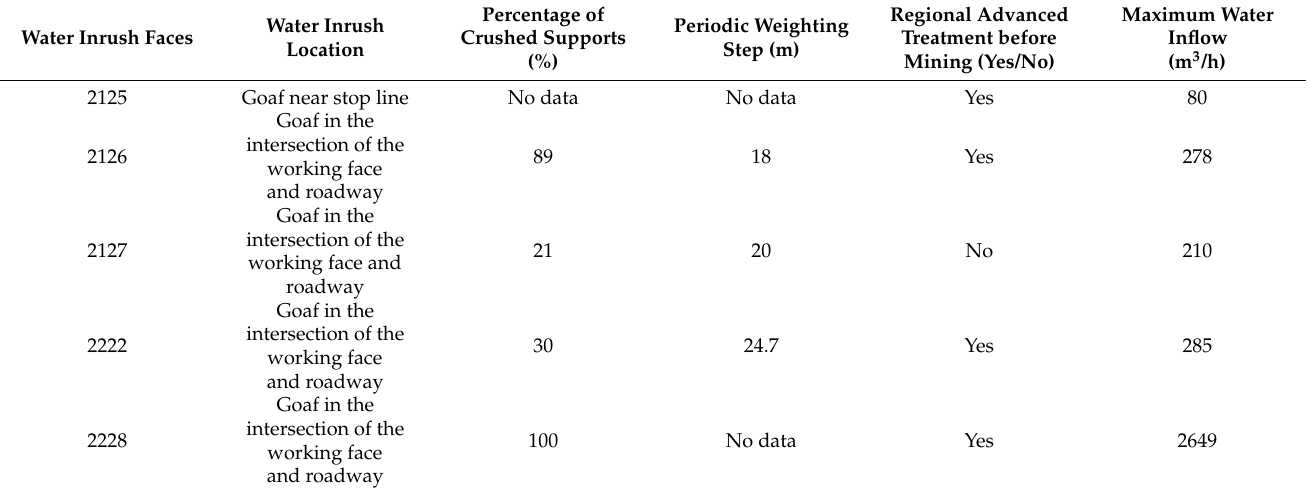
Table 1. Statistics of water inrush